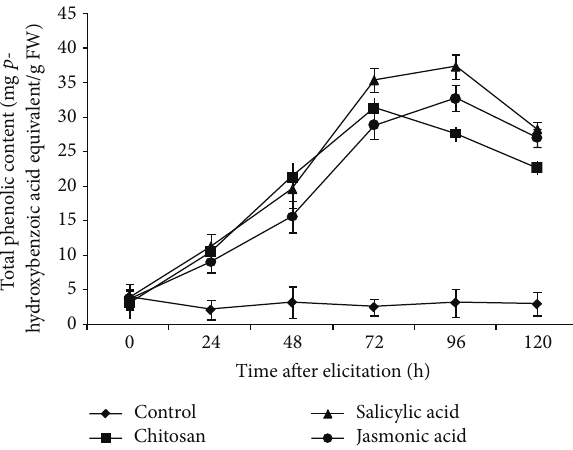
Figure 1: Total phenolic content (expressed as mg 4-hydroxy- benzoic acid equivalent/g FW) in tomato roots on a time course. Each value is the mean ± SD from at least three independent extractions.